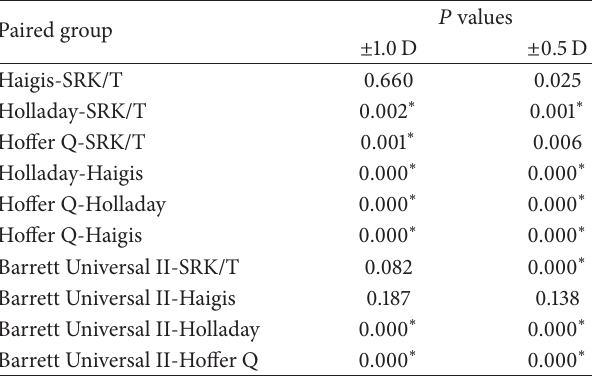
Table 7: Difference in eyes within ± 0.5 D and ± 1.0 D of the target refraction between different